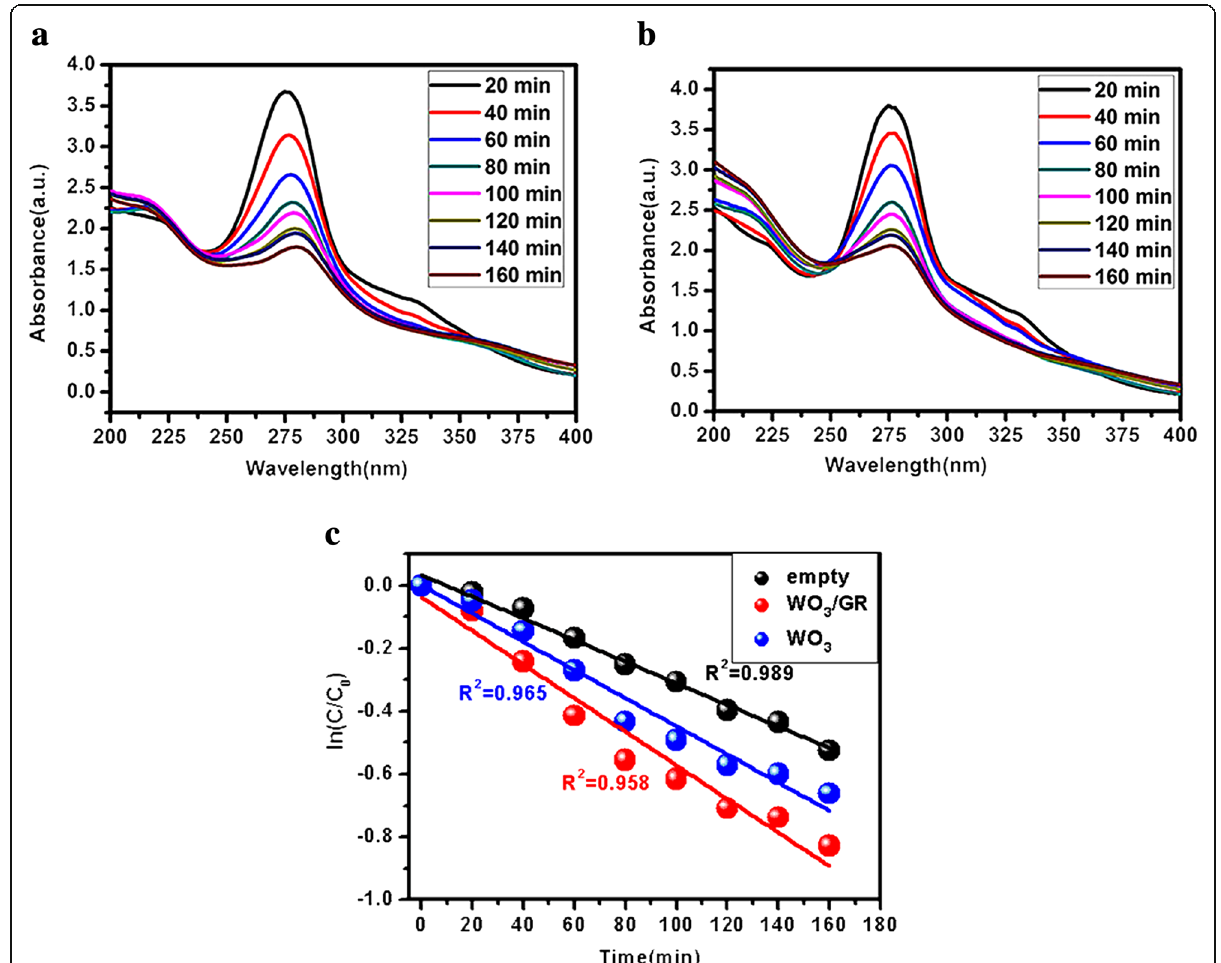
Fig. 3 a UV – vis spectra of the degradation of antibiotics in the presence of WO 3 composites. b UV – vis spectra of the degradation of antibiotics in the presence of WO 3 /GR composites. c Kinetics of as prepared WO 3 and WO 3